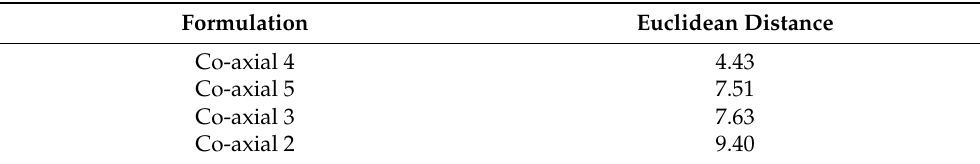
Table 2. Euclidean distance of the drug-loaded co-axial formulations from 20 mg/100 mL or 0.5 mM